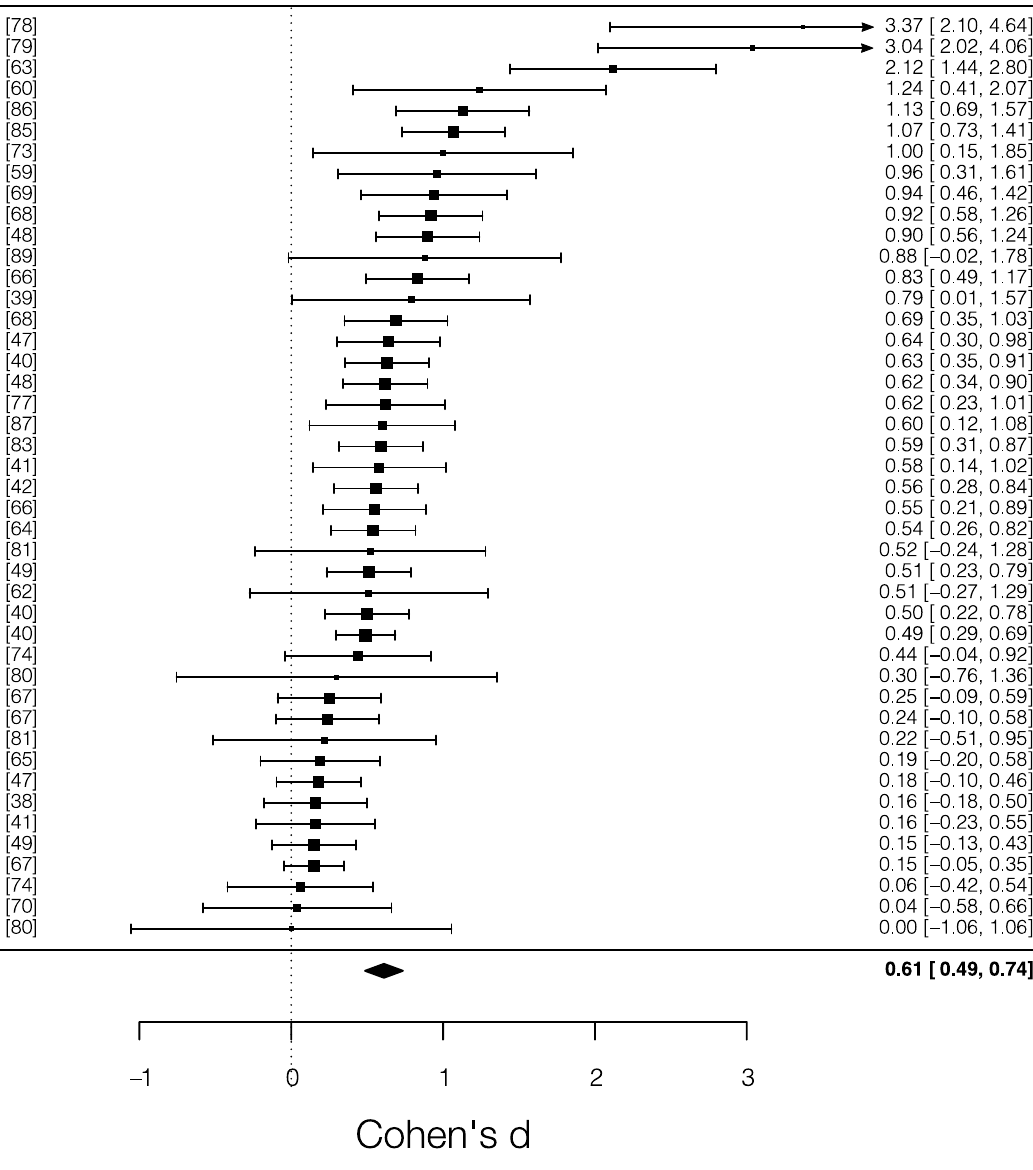
Figure 2. Forest plot of the studies that used accuracy as main dependent variable included in the meta- analysis. Each row corresponds to one experiment and the lines beside each square represent 95% confidence interval. The size of each square represents the weight of the study. The diamond at the bottom represents the cumulative effect size with 95% confidence interval. Higher positive values indicate higher behavioral modulation in the cerebellar TMS